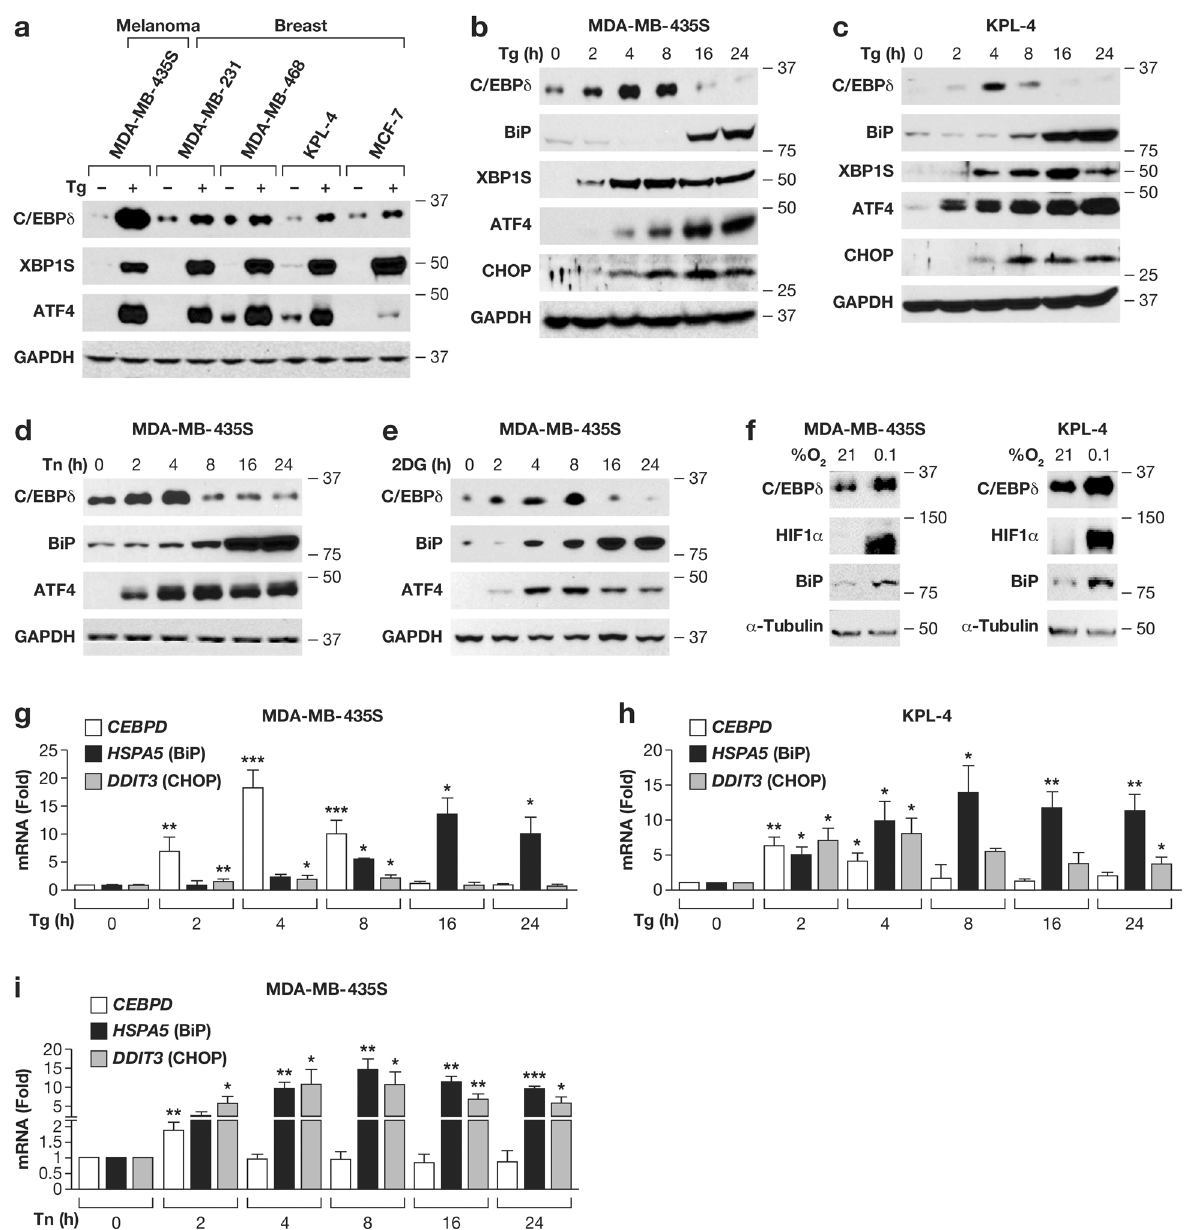
Fig. 1 Endoplasmic reticulum stress modulates C/EBP δ expression in multiple cell lines. a Western blot analysis of the indicated proteins from cell lines representing melanoma and breast cancer treated with 100 nM of Thapsigargin (Tg) for 4 h. b – e Western blot analysis of b MDA-MB-435S or c KPL-4 cells treated with 100 nM Tg for the indicated times, d MDA-MB-435S cells treated with 10 µg/ml Tunicamycin (Tn) or e 10 mM 2-deoxy-glucose (2DG) for the indicated duration (0 h = vehicle treated for 24 h). f MDA-MB-435S and KPL-4 cells exposed to anoxia (0.1% O 2 ) or ambient (21% O 2 ) for 24 h. a – f labels on the right indicate molecular weight in kDa for this and subsequent Figures. g , h qRT-PCR analysis of mRNA levels as indicated in g MDA-MB-435S and h KPL-4 cells treated as in b . i qRT-PCR analysis of mRNA levels in MDA-MB-435S cells treated with 10 µg/ml Tn for the indicated times. Data are represented as mean±S.E.M, n = 3, * P < 0.05, ** P < 0.01, *** P <